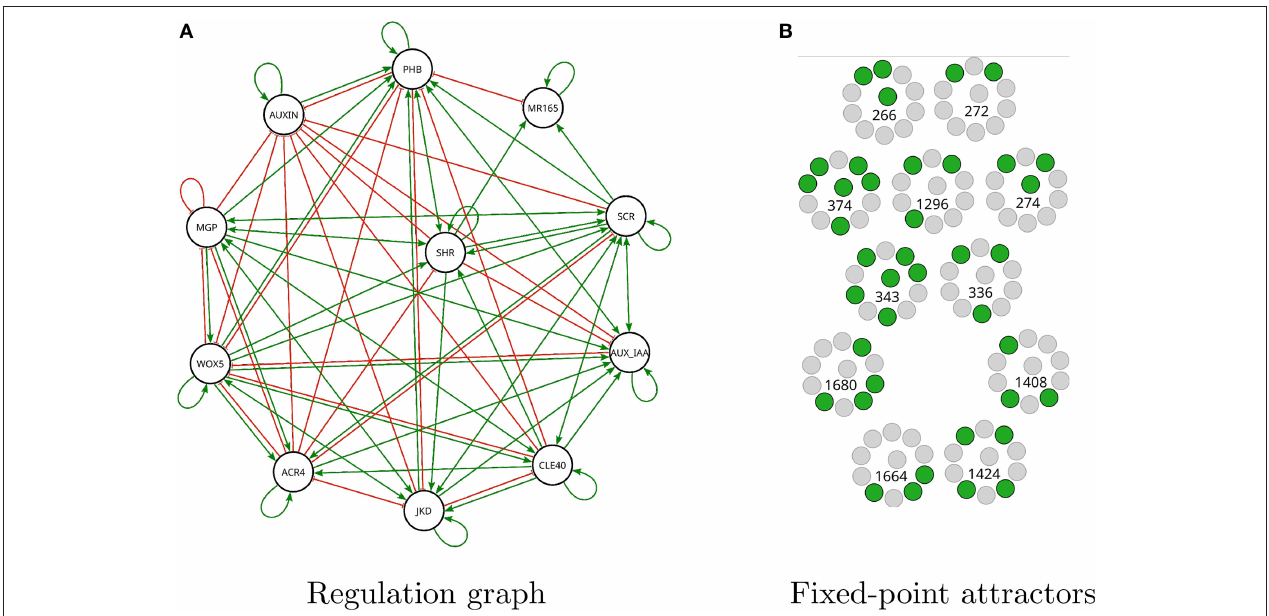
FIGURE 9 | Modified A. thaliana root Boolean network found by Griffin satisfying question 7. (A) Interaction graph of the solution has 83 regulations of the 90 possible (see Figure 3D ). (B) There are 11 fixed-point attractors in the solution. For each expression profile active genes are shown in green while inactive genes are shown in gray. The number corresponds to the decimal notation used in Table S1 in Supplementary